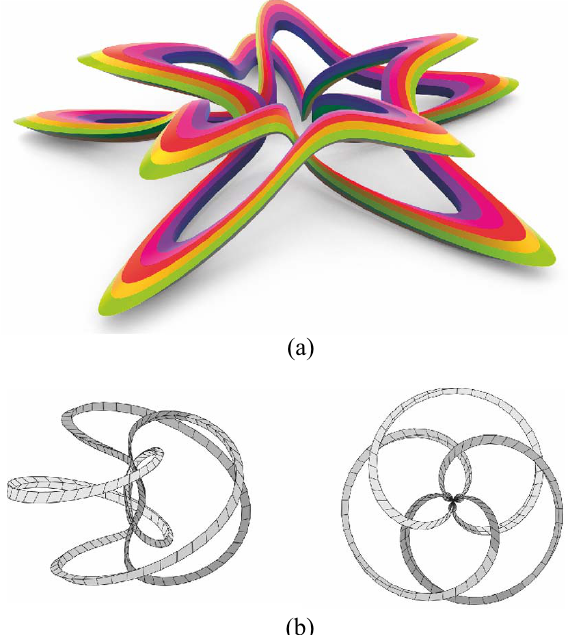
Figure 4. (a) GML 0 surface (Architon) with six different sectors in different colours and, (b) some results after separating the 6 different